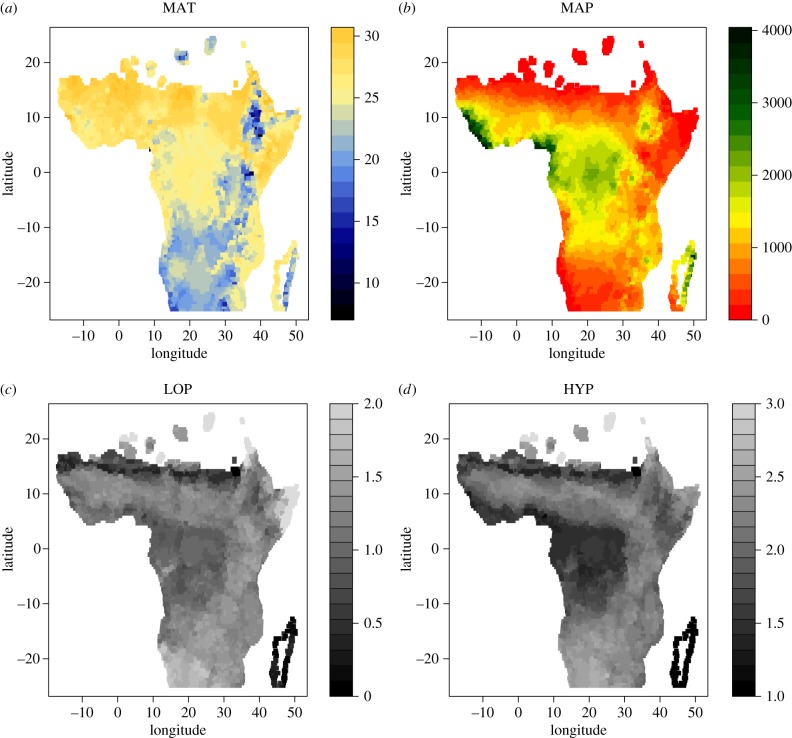
(a–d) Visualization of the modern-day data used for modelling.